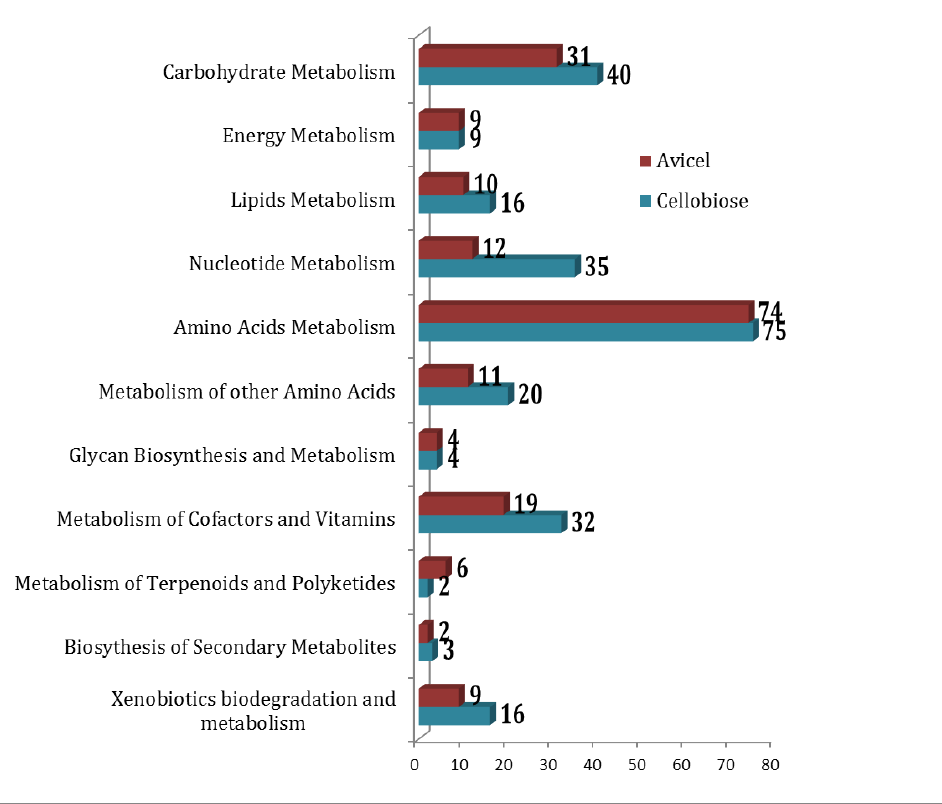
Figure 1. Distribution of compounds under the metabolic pathways as detected in cellobiose (blue) and Avicel (red) media condition formulation.